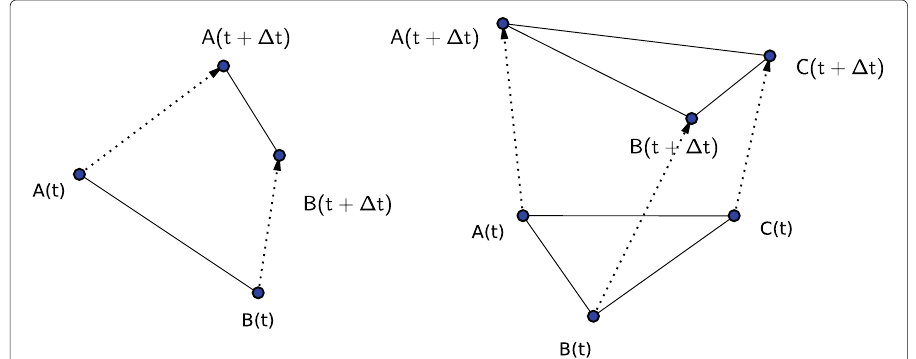
Fig. 1 Schematics for space-time integration at an edge (left) and cell